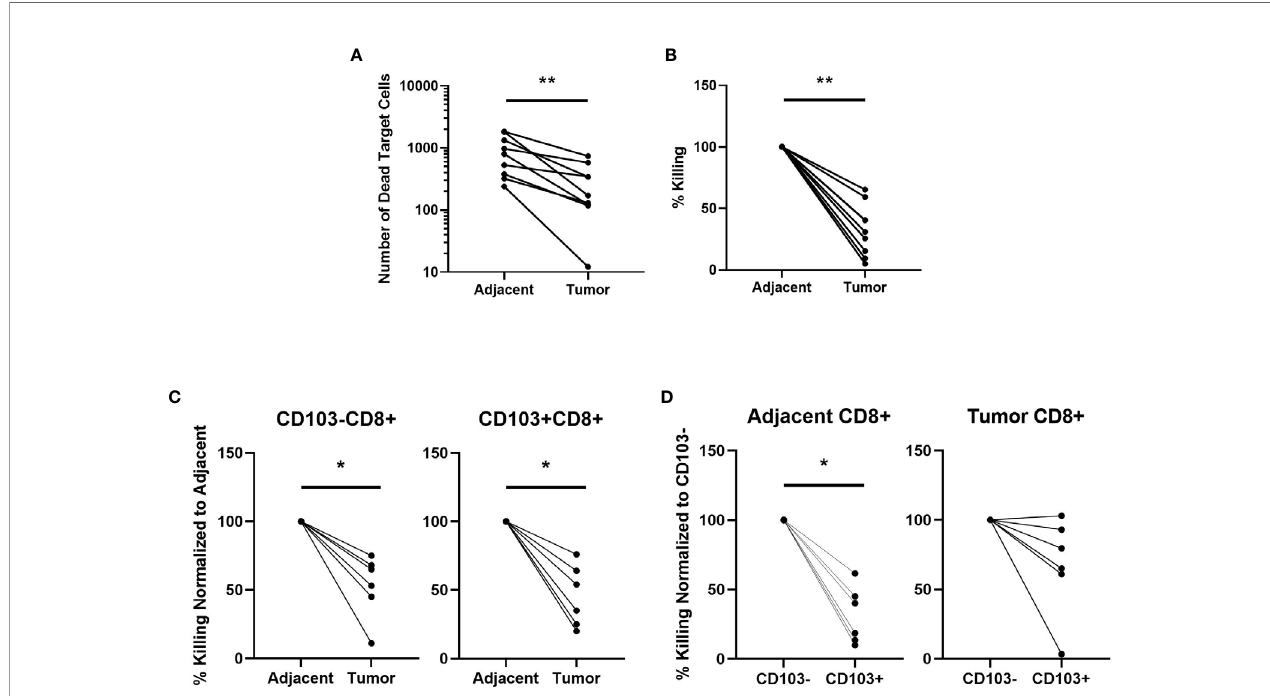
FIGURE 2 | CD8+ T cell Cytotoxic Killing is Suppressed in Endometrial Carcinomas Compared to Adjacent Non-Cancerous Tissue. The capacity of total CD8+ T cell cytotoxic killing of allogeneic target cells was determined using an IncuCyte Zoom and expressed as the difference in number of dead target cells (A) and the percentage dead cells in adjacent non-cancerous tissue (B) over 4hrs. The value of killing in each endometrial carcinoma is expressed as percentage of its matched adjacent non-cancerous tissue which is set to 100% (B) . CD8+ T cells were separated into CD103- or CD103+ subpopulations from both the adjacent non- cancerous endometrium or endometrial carcinoma and cytotoxic capacity determined by IncuCyte Zoom comparing adjacent CD103- versus tumor CD103-CD8+ T cells and adjacent CD103+ versus tumor CD103+CD8+ T cells (C) over 4 hrs. Cytotoxic killing of allogeneic target cells by tumor CD103+ and CD103- CD8+T cells is normalized to % killing by adjacent CD103+ or 103- CD8+ T cells, which is set to 100%. Cytotoxic killing was also determined between adjacent CD103- versus adjacent CD103+, and tumor CD103- versus tumor CD103+ (D) cells over 4hrs. In D, cytotoxic killing of allogeneic target cells by CD103+CD8+ T cells is expressed as a percentage of killing by CD103-CD8+ T cells, which is set to 100%. Each circle represents an individual patient. *p<0.05, **p<0.01. Wilcoxon matched-pairs signed rank ( Figure 2C ) CD8+ T cells. In both populations, tumor CD8+T cells had signi fi cantly lower cytotoxic killing of allogeneic target cells than CD103- and CD103+CD8+ T cells from adjacent non- cancerous tissue. In adjacent non-cancerous endometrial tissues ( Figure 2D ), we found that cytotoxic killing by CD103+CD8+ T cells was signi fi cantly lower than that seen with CD103-CD8+ T cells.